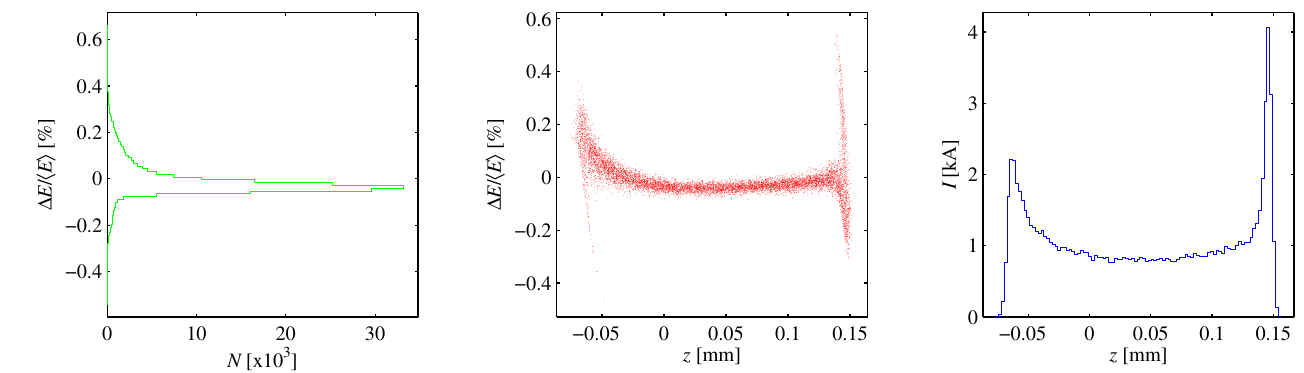
FIG. 12. (Color) Energy profile (left), longitudinal phase space (middle), and bunch current distribution (right) at the linac end when the one-stage compression option as described in [4] is considered. Bunch mean energy h E i ¼ 1067 MeV .